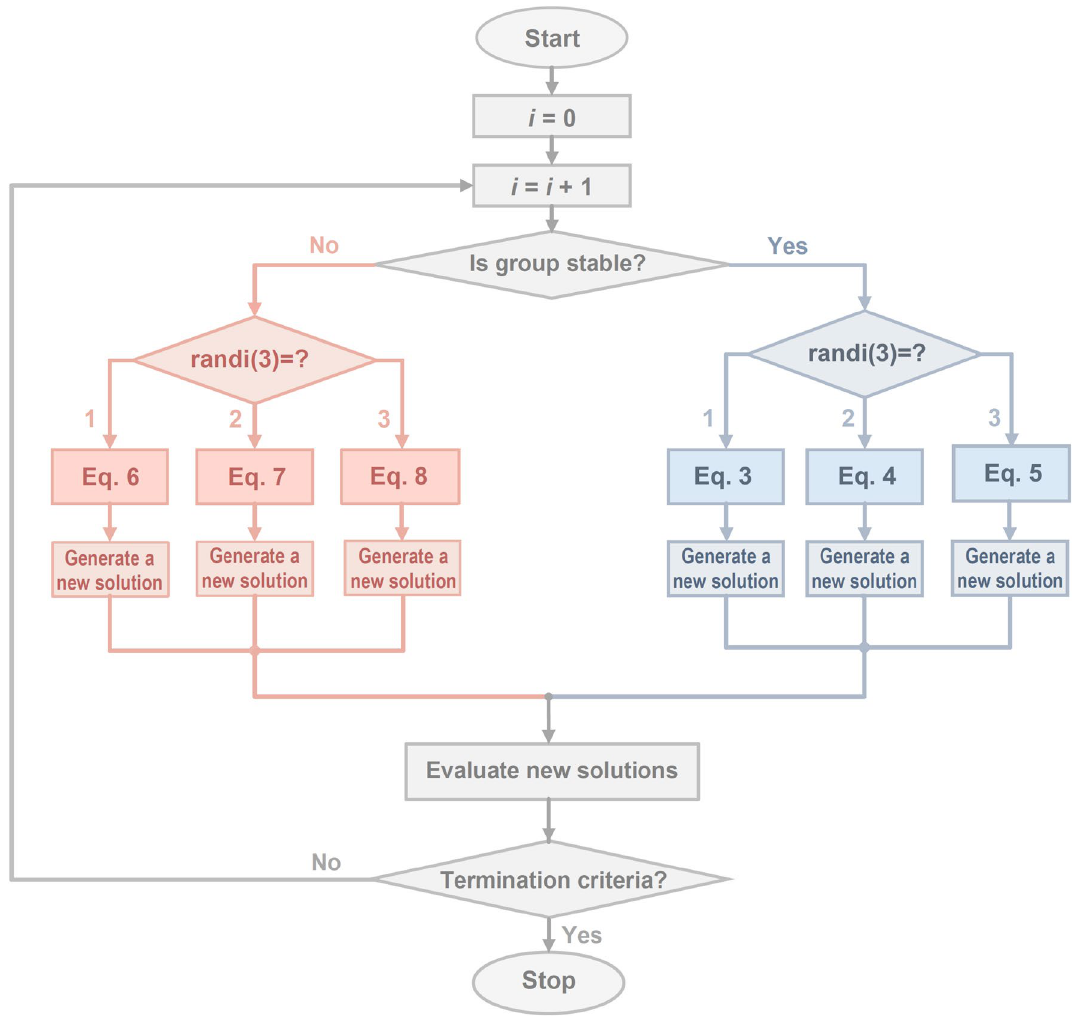
Figure 11. Flowchart of the process of determining groups and reactions in each iteration for each